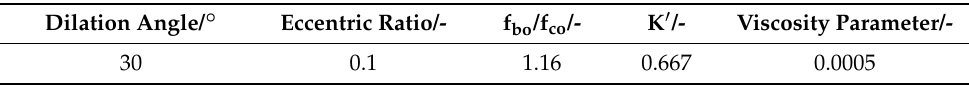
Table 3. The parameters of concrete plastic damage